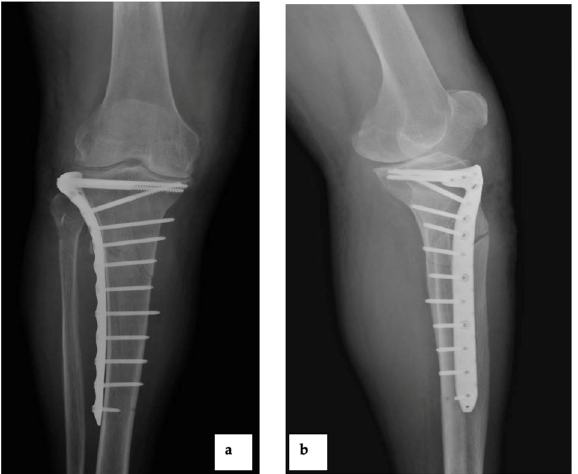
Figure 4. The plain radiograph showed the infected tibial plate (( a ): anteroposterior view and ( b ): lateral view).